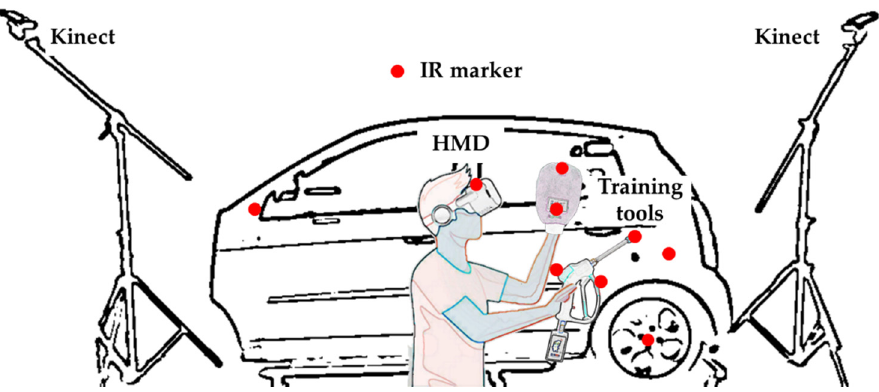
Figure 1. Overview of job training system in VR environment using multiple sensors.